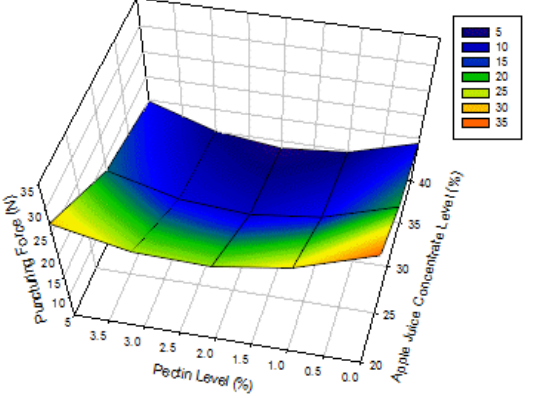
Figure 4. Surface plots for puncturing force of apple-blackcurrant fruit leather as affected by apple juice concentrate and pectin levels with a blackcurrant concentrate level of 6% (legend shows the range of values on the response surface).